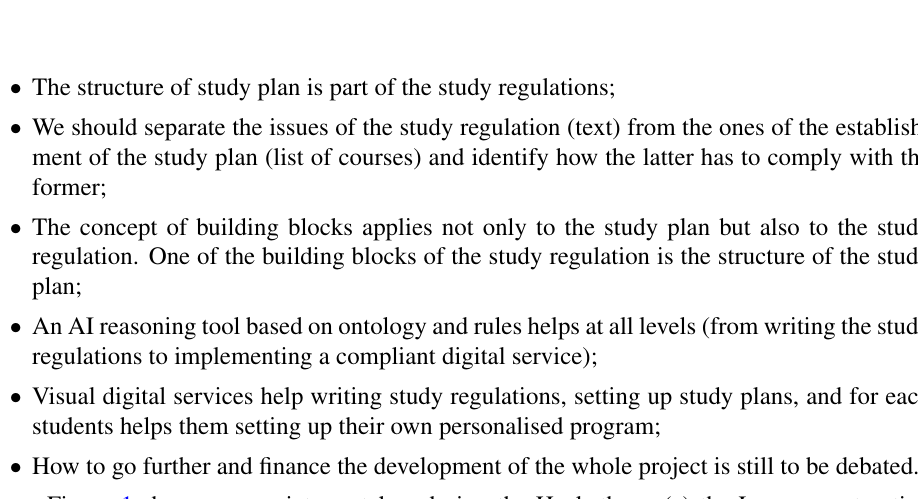
Table 1: Concepts and Constraints of Study Regulation of the Bachelor in